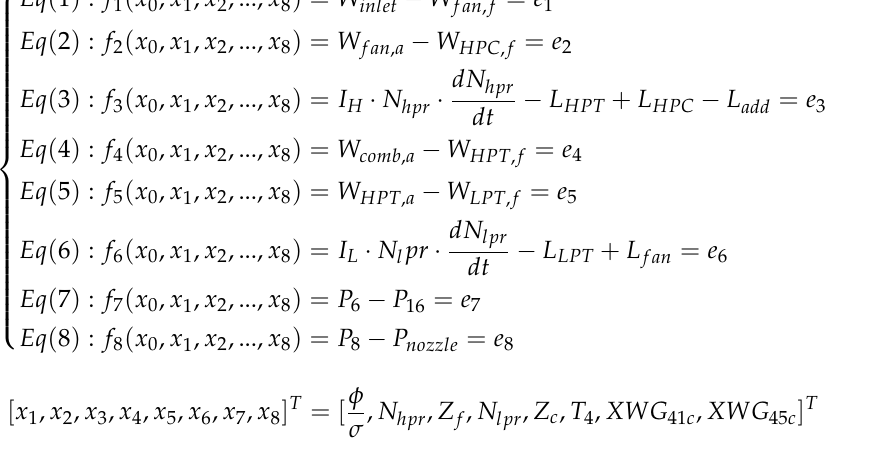
Figure 2. The main workflow of intet/engine integrated component-level model. In addition, the output parameters of each gas path component model are governed by a common set of operating equations. Typical common equations include the pressure balance between the pressurized combustion chamber and nozzle, and the flow balance between the compressors of the fan; the power consumed on the same shaft should form a balance with the power generated. To achieve the inlet/engine matching, the residuals of the inlet and fan flows are taken as the balancing equations, and the ratio of the flow coefficient/total pressure recovery coefficient ( φ ) is chosen as the starting guess for the σ iteration. If the number of iterative variables is the same as the balancing equations, the problem is transformed into a nonlinear implicit set of equations with unknown independent variables, and the component-level model is considered to have a reliable solution when the residuals tend to zero. The hybrid iterative algorithm of the damping Newton method [32] is utilized to solve the issue due to the rise in iterative variables. [ x ] T denotes the independent assignment variables for the iterative 1 , x 2 , x 3 , x 4 , x 5 , x 6 , x 7 , x 8 process. The iterative variables ( e ) are selected, and co-working equations (Eq) are solved in association, expressed as